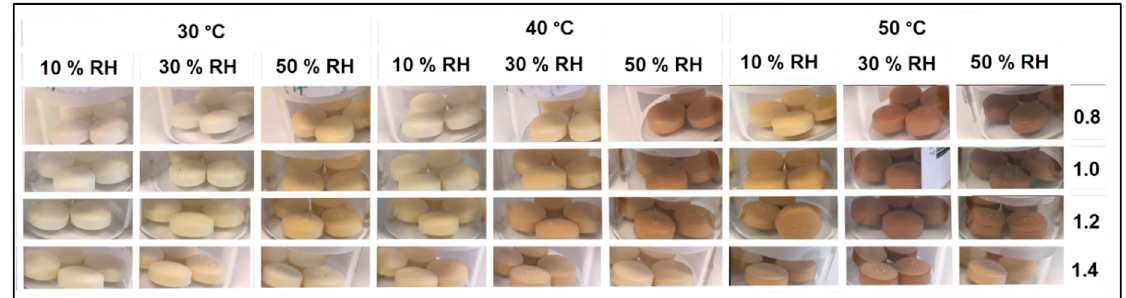
Abbreviations: polyethylene glycol (PEG), saxagliptin (SAXA).